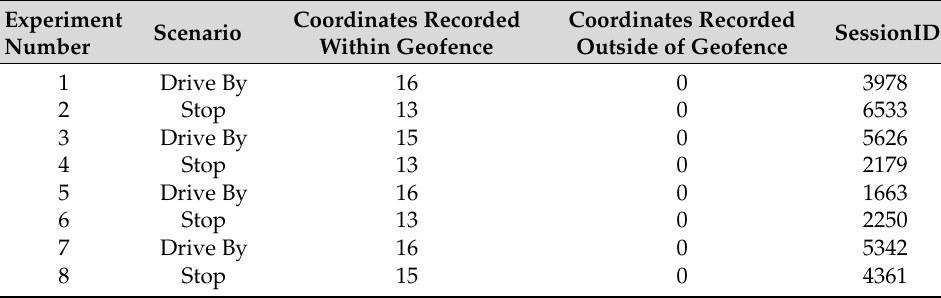
Table 6. Number of Coordinates Collected during each experiment.